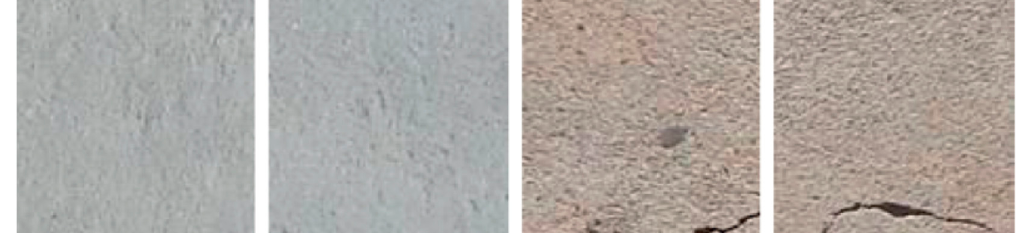
Figure 19. Noncrack and crack images form SDNET2018 dataset.